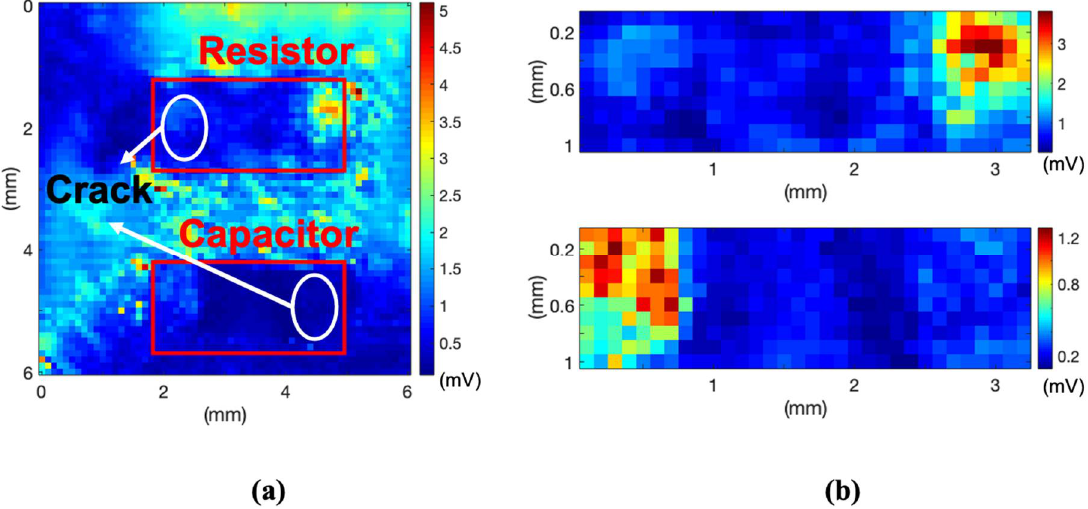
Figure 6. ( a ) C-mode image and ( b ) partial image of red rectangle area.